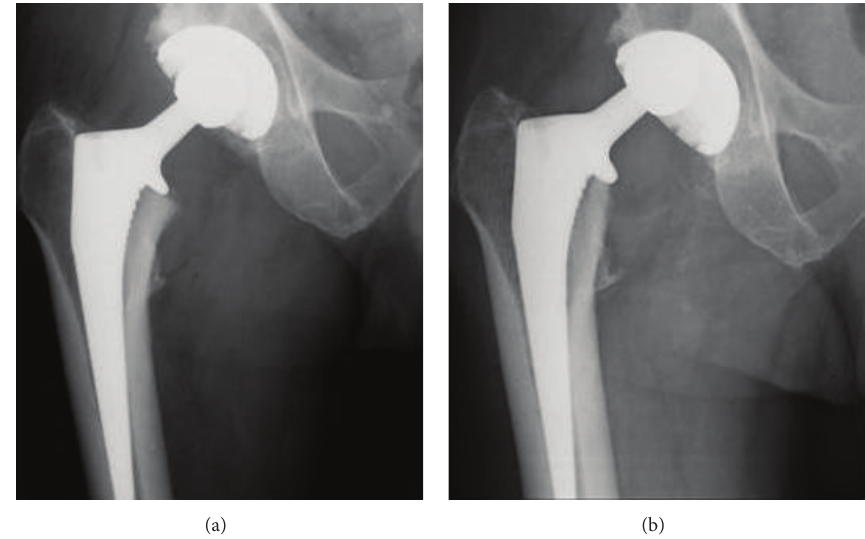
Figure 1: (a) Previous AP Hip X-ray demonstrates satisfactory component positioning. (b) AP Hip X-ray from ED attendance demonstrates acetabular liner dissociation. Comparison to (a) shows grossly eccentric superior migration of the femoral head within the acetabular shell.